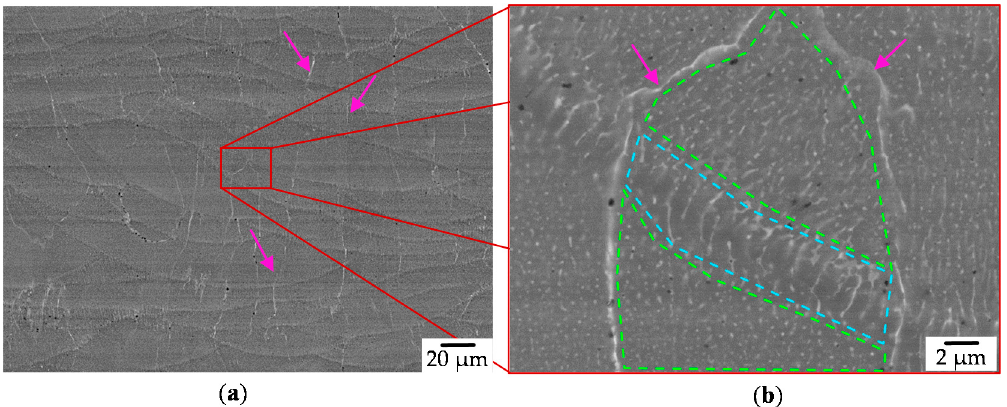
Figure 12. AsB Picture for sample Figure 8c. Purple arrows mark grain boundaries, blue dashed region a cellular structure at the weld seam and green most likely a degenerated columnar structures (EHT = 20 kV, WD = 8.7 mm, IProbe = 1.5 nA, ESB Grid 1000V, ( a ) Mag. 1000×, ( b ) 10.000×). 20 kV, WD = 8.7 mm, IProbe = 1.5 nA, ESB Grid 1000V, ( a ) Mag. 1000 × , ( b ) 10.000 × ).